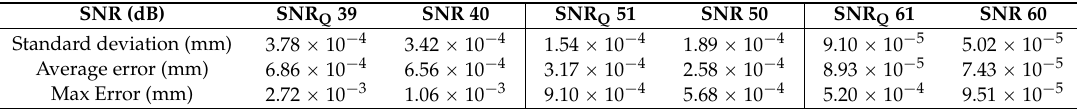
Table 4. Errors due to quantization noise, and comparison with measured errors due to